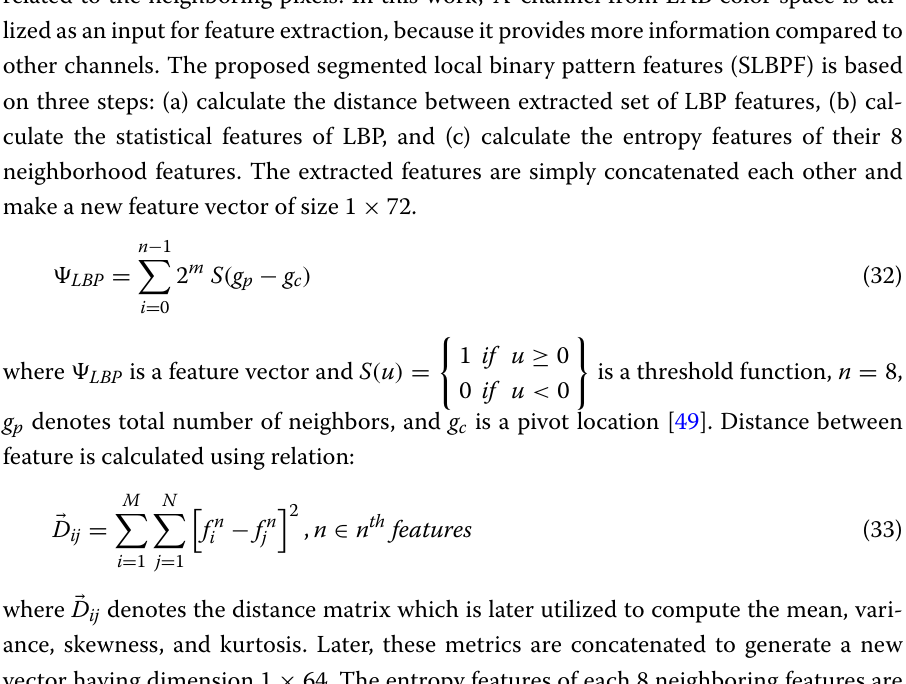
computational time. A complete mathematical description of each feature is provided in Table 3, and the final vector size is 1 ×